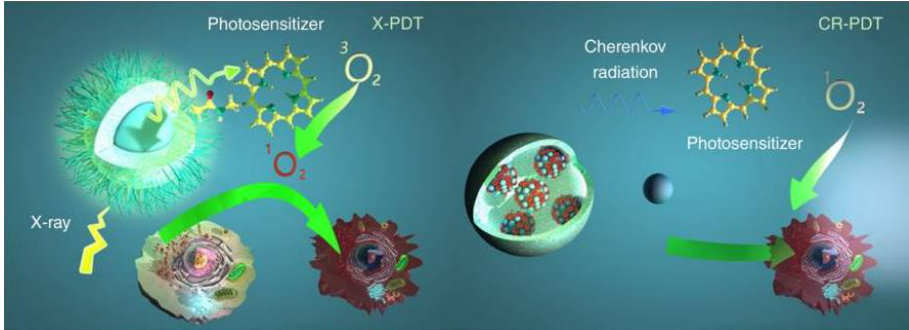
Figure 7. Schematic illustration for X-PDT and CR-PDT. Left: Classic X-PDT. X-rays excite a nanoscintillator to generate X-ray luminescence, which in turn activate a PS to produce cytotoxic ROS. Right: Cherenkov radiation PDT. Cherenkov radiation from radioisotopes is harnessed to activate a PS to initiate PDT. Reproduced with permission from B. Cline et al. Wiley Interdisciplinary Reviews. Nanomedicine and Nanobiotechnology published by Wiley, 2019 [182].